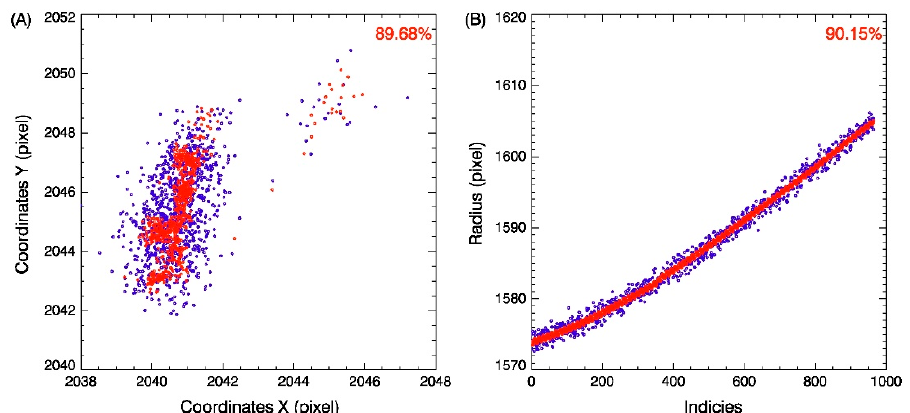
Figure 9. The image data was obtained from 1 August 2021 to 31 October 2021, and the solar activity was moderate. ( A ) is the comparison of the 965 samples of solar centers between our calculations (blue points) and the results of AIA (red points), and ( B ) is the comparison of the 970 samples of solar radii between our calculations (blue points) and the results of AIA (red points).